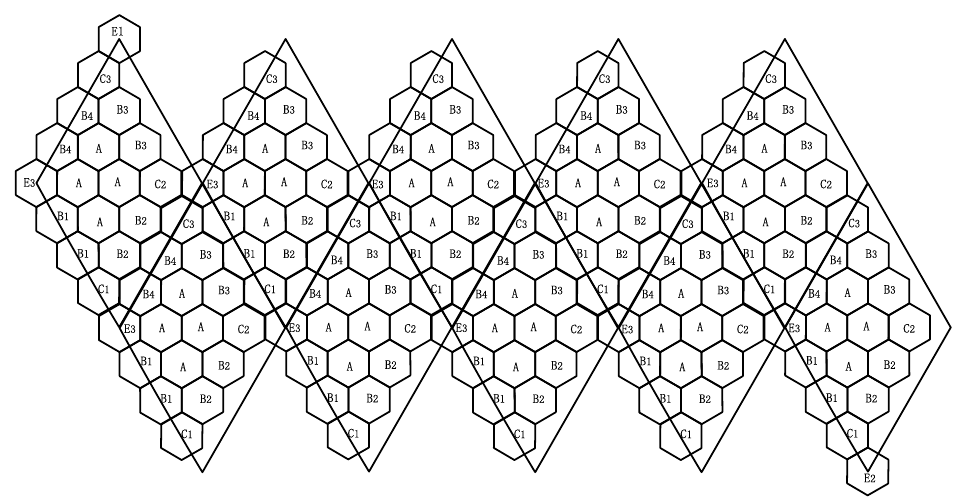
Figure 8. Icosahedral hexagonal cell type.